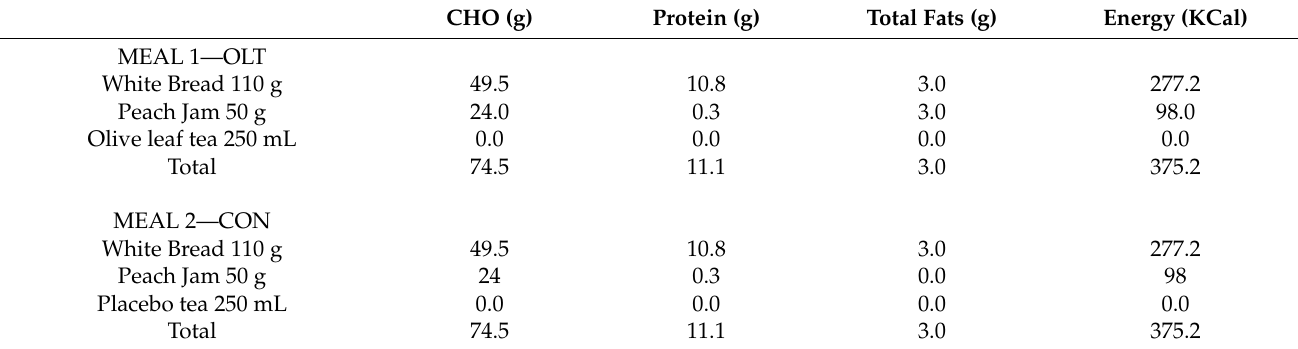
Table 1. Composition of the mixed breakfast